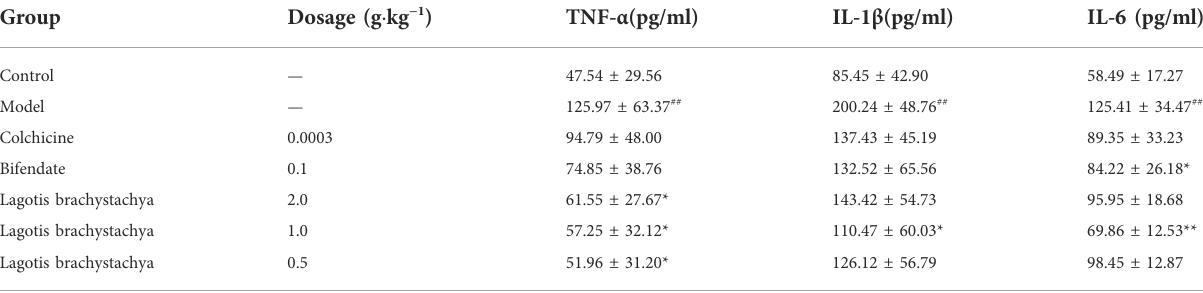
TABLE 2 Effects of total extract of Lagotis brachystachya on serum TNF- α , IL-1 β ,and IL-6 of rats with chronic alcoholic liver injury and gouty arthritis (x ± s , n = 8). Group